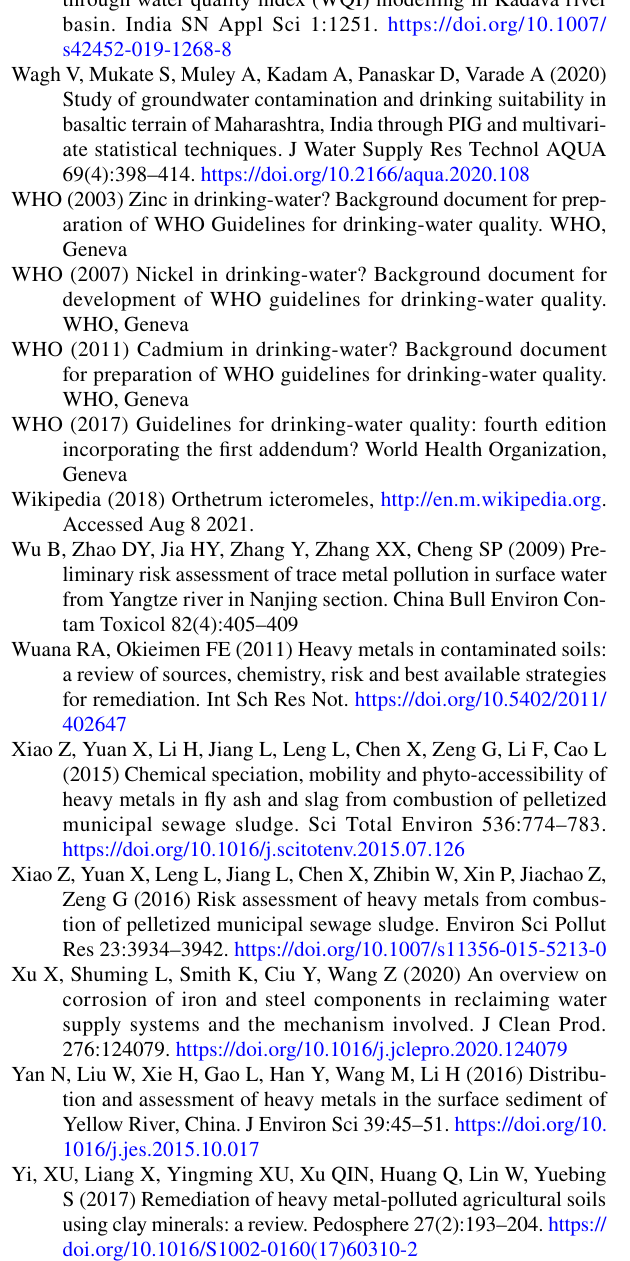
Table (TR=1E-06, HQ=1). https:// www. epa. gov/ risk/ regio nal- scree ning- levels- rsls- gener ictab les. Assessed on Nov